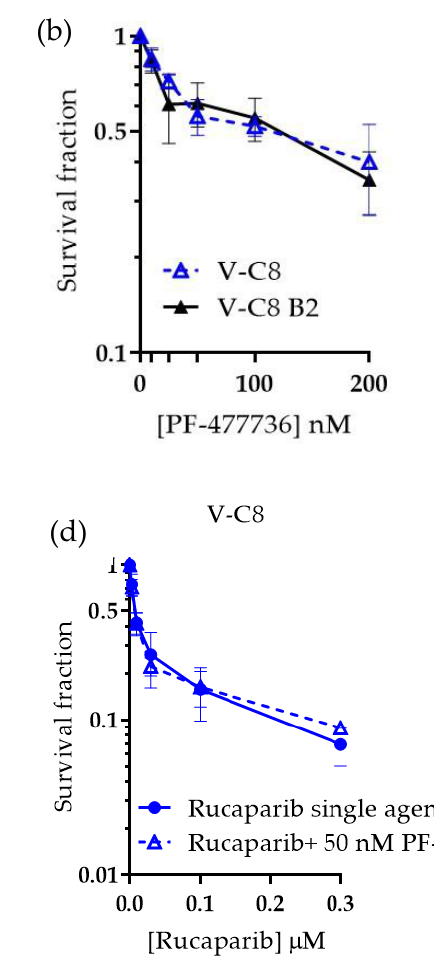
Figure 1. Di ff erential cytotoxicity and synergy of rucaparib and PF-477736 in BRCA2 mutant and corrected cells. V-C8 and V-C8.B2 cells were exposed to drugs at the indicated concentration for 24 h prior to replacement with drug-free medium for 7–10 days to allow colony formation. ( a ) Rucaparib, ( b ) PF-477736, ( c ) the combination of rucaparib with 50 nM PF-477736 in V-C8 B2 cells, and ( d ) the combination of rucaparib with 50 nM PF-477736 in V-C8 cells. Data are the mean and standard error of three independent experiments.